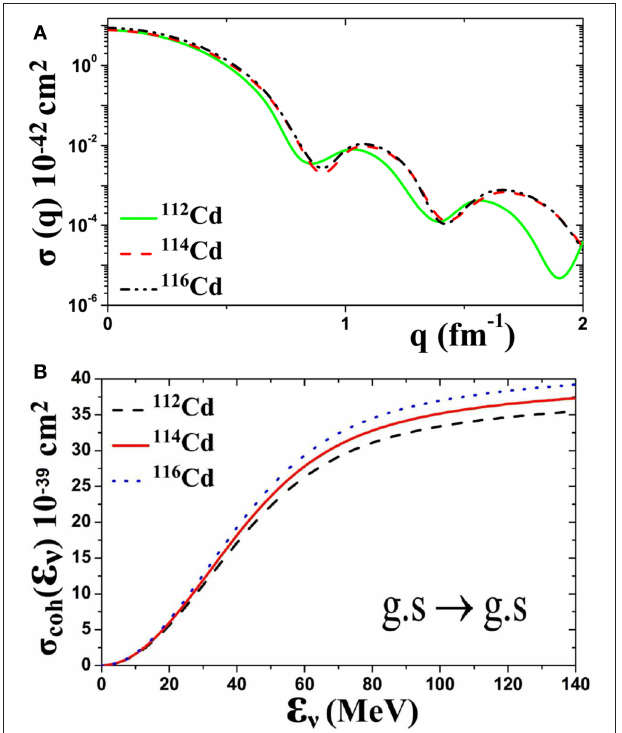
FIGURE 2 | Total cross sections of coherent (ground state to ground state g . s . g . s .) transitions for the neutral current reactions → 112,114,116 Cd( ν 112,114,116 Cd l , ν ′ l ) ∗ , l = e , µ , τ , as a function of (A)